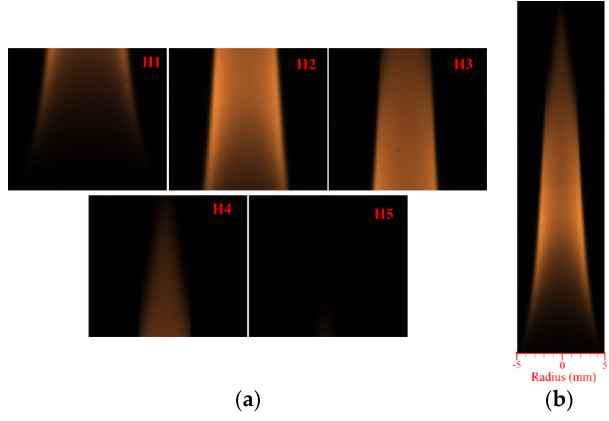
Figure 7. Five different parts of a flame ( a , b ) the composite image.